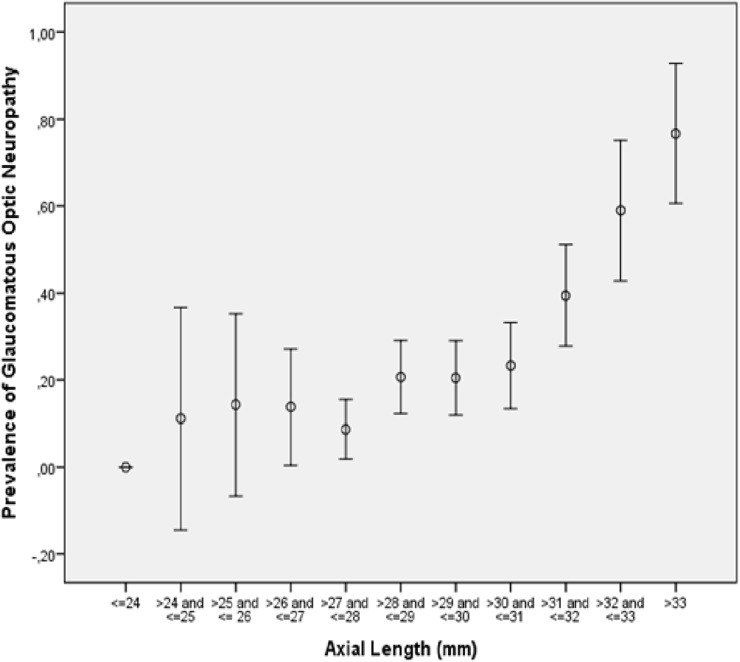
Graph Showing the Distribution of the Prevalence of Glaucomatous Optic Neuropathy and Axial Length.